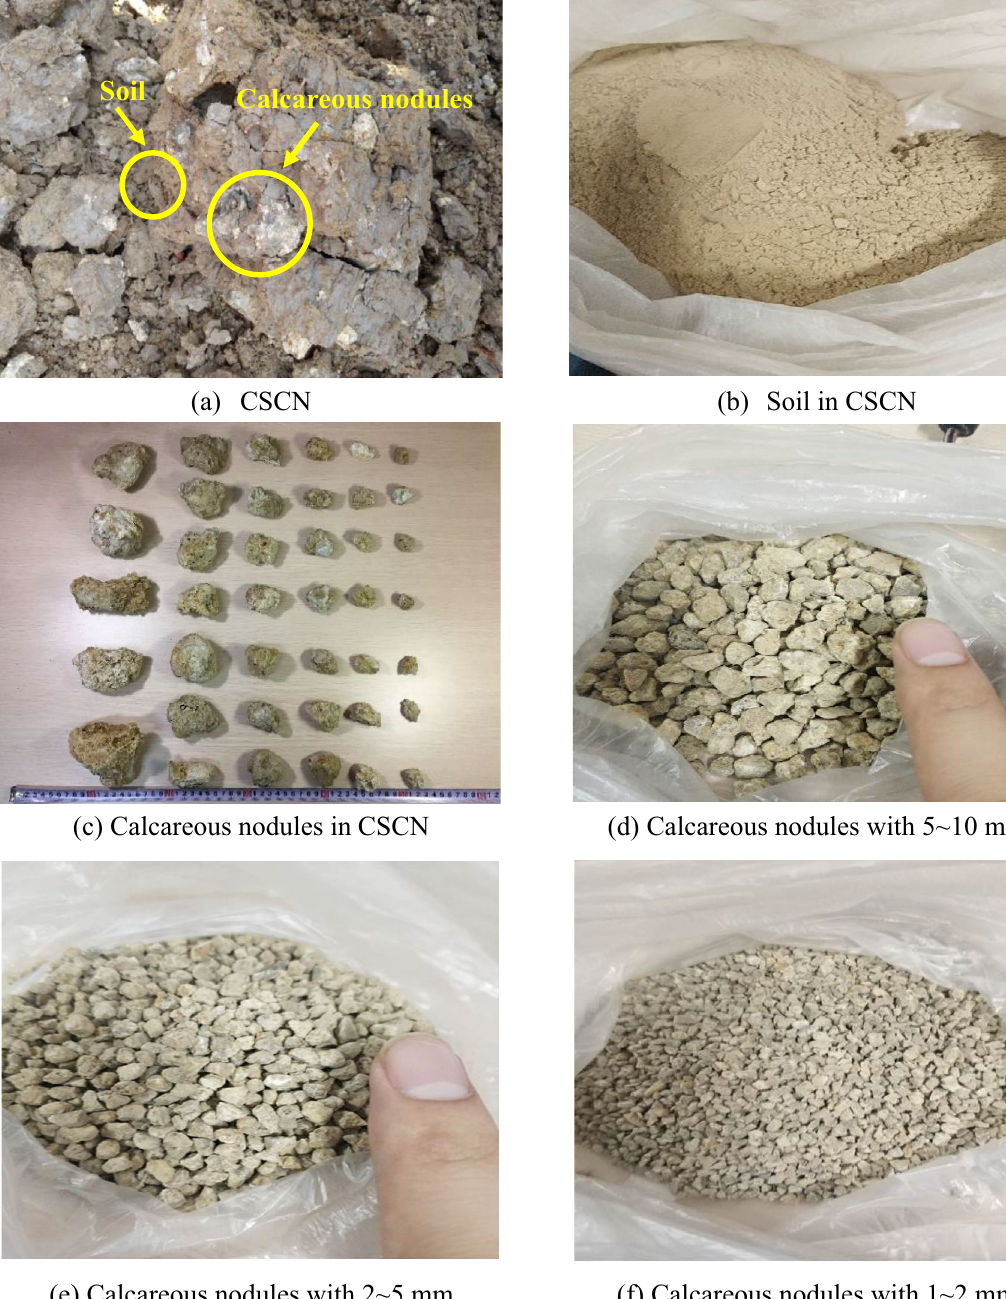
Figure 2. Typical constituents and structural characteristics of